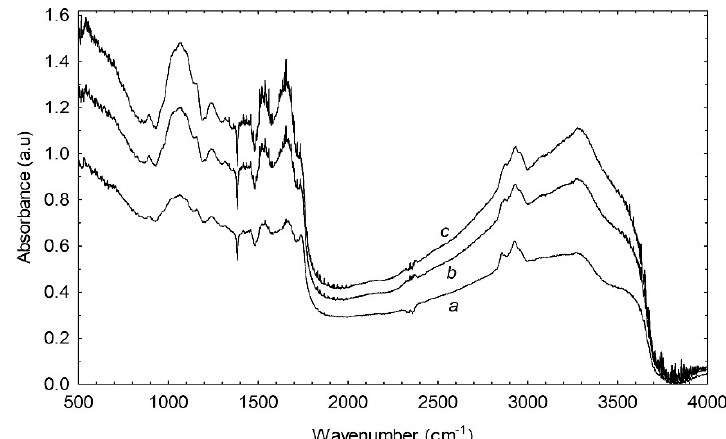
Figure 5. FTIR spectra of dark-grown ( a ) chia microgreens and microgreens after exposure to light for 24 ( b ) and 48 ( c ) h. FTIR spectrum was recorded by 20 co-added scans at a resolution of 2 cm − 1 in the region of wave number (WN) 500 to 4000 cm − 1 . The spectra were baseline-corrected. Table 2. Main bands in the FTIR spectra and their assignments of dark-grown chia microgreens and microgreens after exposure to light for 24 and 48